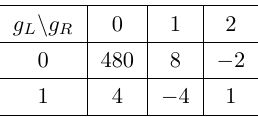
for the homology class β = ( d β